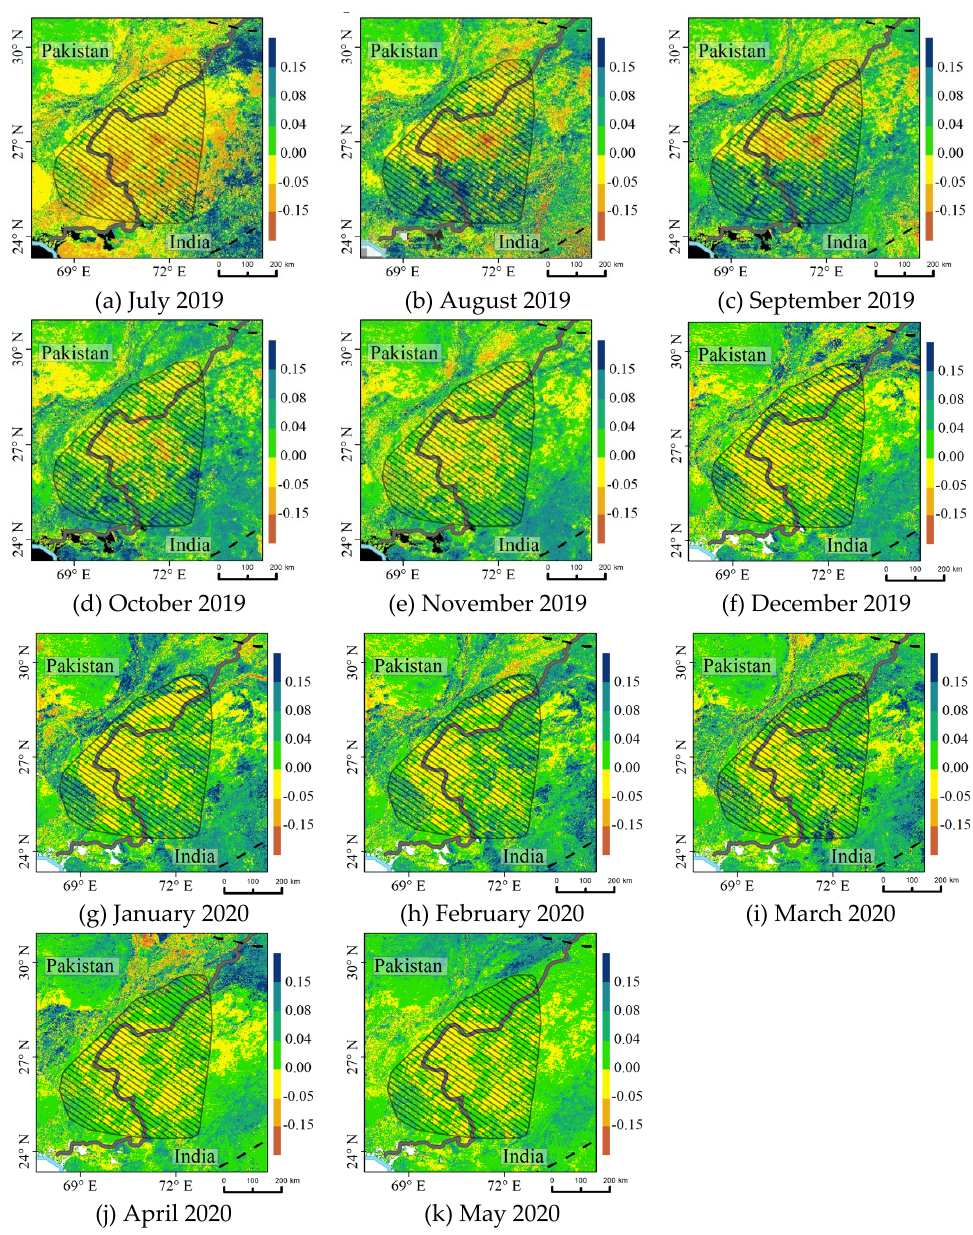
Figure 7. Spatial–temporal patterns of the NDVI anomalies near the Indo-Pakistan border from July 2019 to May 2020.